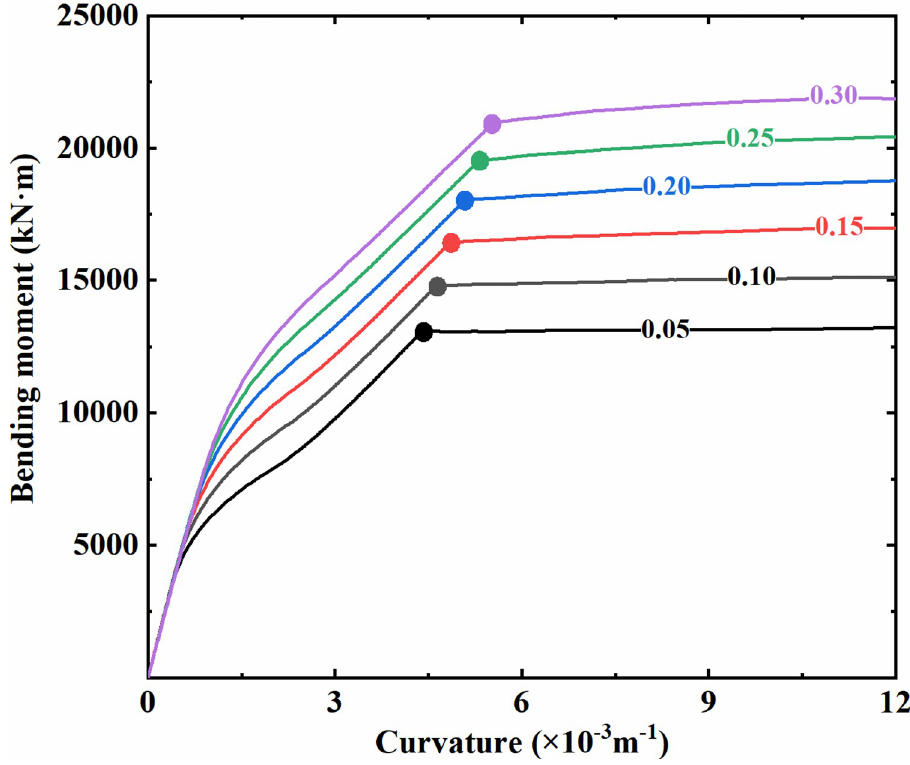
Fig 14. Bending moment-curvature curves of the sidewall section with different axial compression